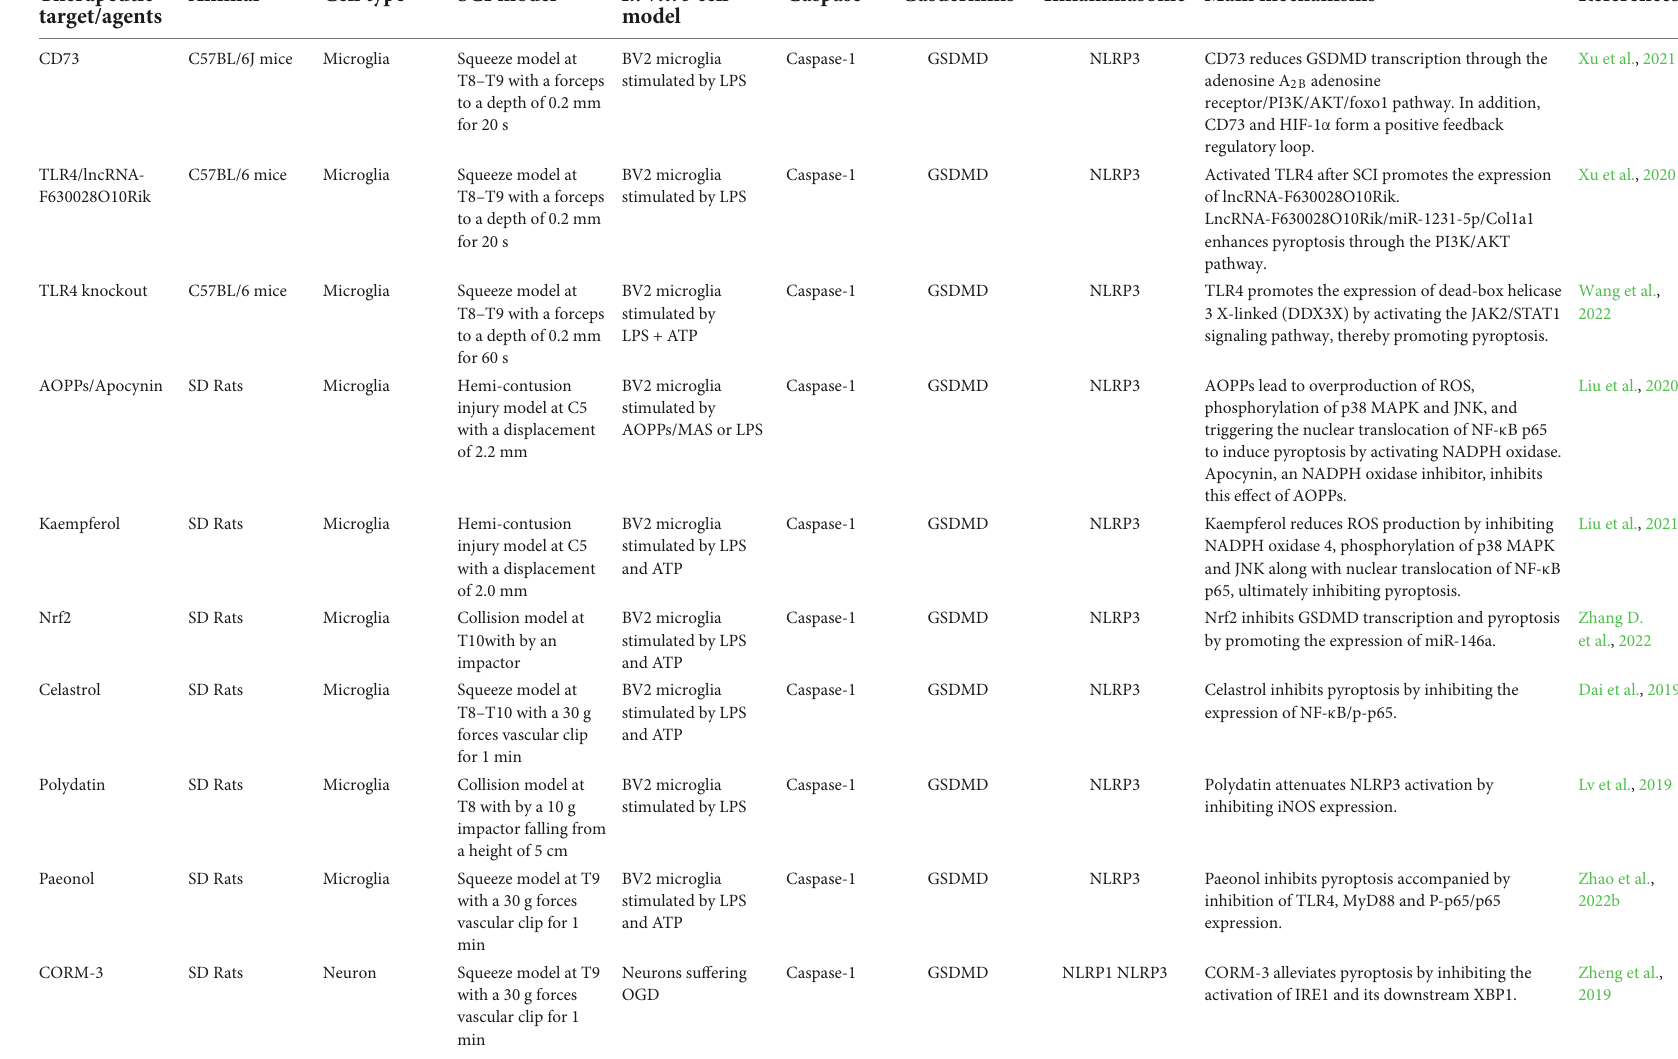
TABLE 1 SCI experiments centered on